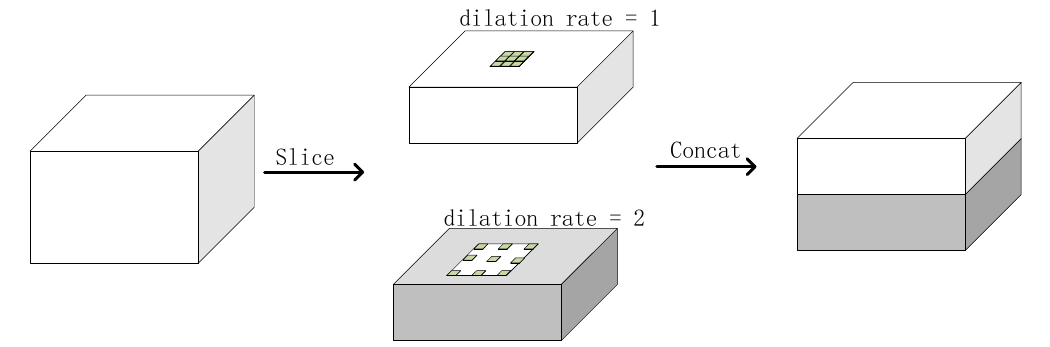
Figure 4. The illustration of the context